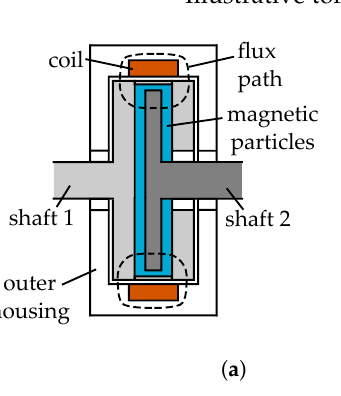
Figure 8. Magnetic particle type clutch: ( a ) Cross-section ( b ) Assembled view [34]. Reproduced with permission from Kendrion, Magnetic particle clutches, brakes and controllers. ( c ) Ideal torque vs. slip speed